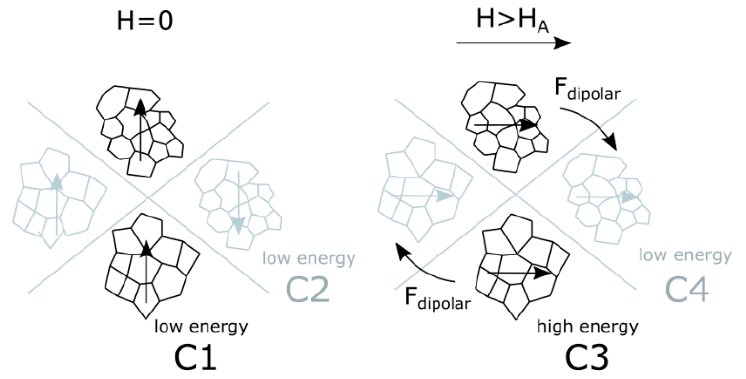
Figure 10. Schematic diagram explaining the mechanism of arising of dipolar interactions leading to the displacement of aggregates of CFO NPs: in zero magnetic fields (explanation is in the text).